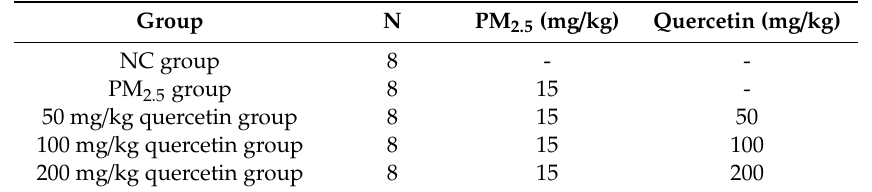
Table 1. Animal treatment.